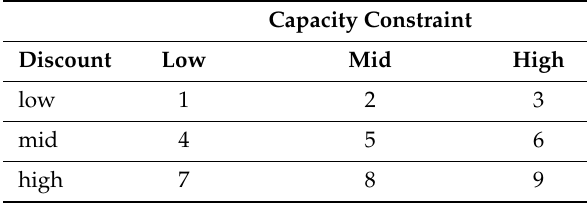
Table 1. Nine Treatments categorized on the discount and capacity